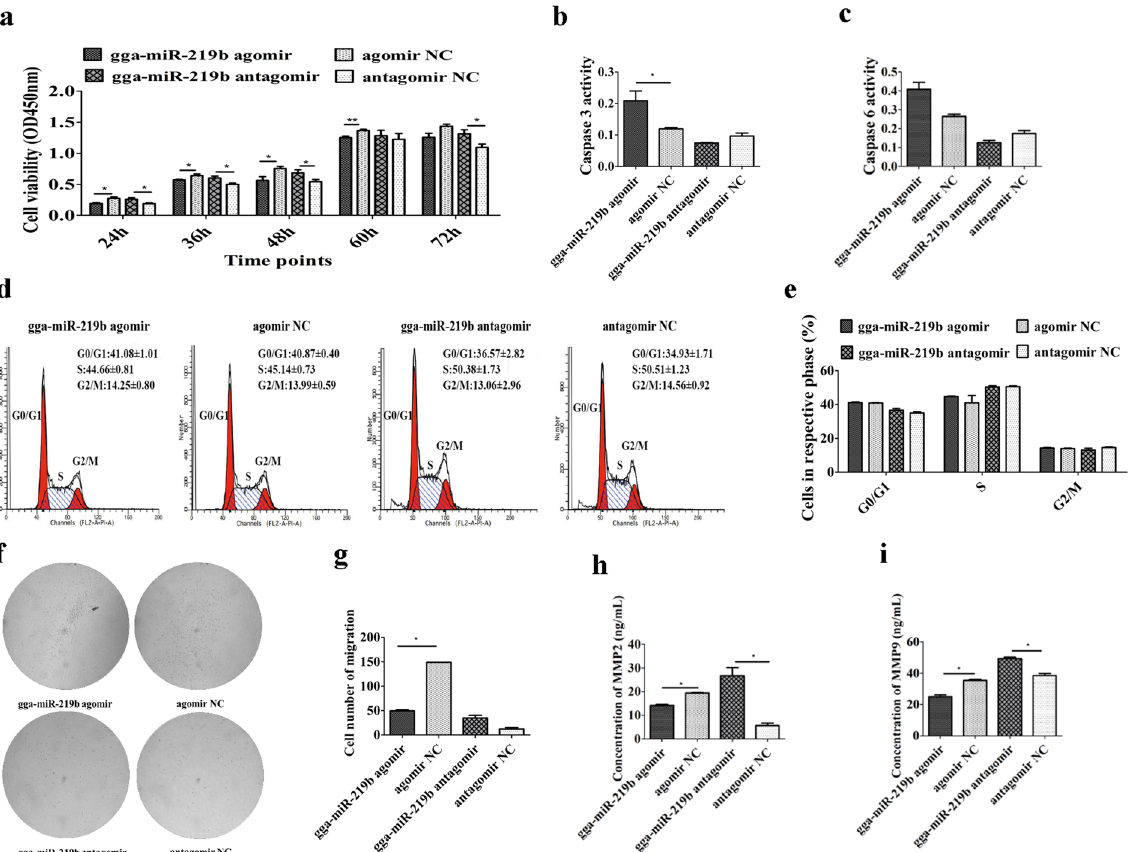
Figure 1. Effect of gga-miR-219b on cell proliferation, migration and invasion in MSB1 cells. ( a ) Effect of gga-miR-219b on MSB1 cell proliferation. Cell proliferation was detected by a CCK-8 assay at 24 h, 36 h, 48 h, 60 h and 72 h after transfection with the gga-miR-219b agomir, antagomir or respective NC (n = 5). ( b,c ) Effect of gga-miR-219b on MSB1 cell apoptosis. The activity of caspase-3 ( b ) and caspase-6 ( c ) was detected after transfection with the gga-miR-219b agomir, antagomir or respective NC (n = 3). ( d ) Representative histograms depicting cell cycle profiles of MSB1 cells transiently transfected with the gga-miR-219b agomir, antagomir or respective NC (n = 3). ( e ) Proportion of cells in various phases of the cell cycle (n = 3). ( f ) Representative images depicting cell migration profiles of MSB1 cells transiently transfected with the gga-miR-219b agomir, antagomir or respective NC (n = 2). ( g ) Effect of gga-miR-219b on MSB1 cell migration. Transwell migration assay performed after transduction of the gga-miR-219b agomir, antagomir or respective NC (n = 2). ( h,i ) Protein level of MMP2 ( h) and MMP9 ( i) after transduction of the gga-miR-219b agomir, antagomir or respective NC (n = 3). Differences between the two groups were analysed by Student’s t -test with the SAS system. The data are expressed as the mean ± S.E. * P < 0.05. ** P <